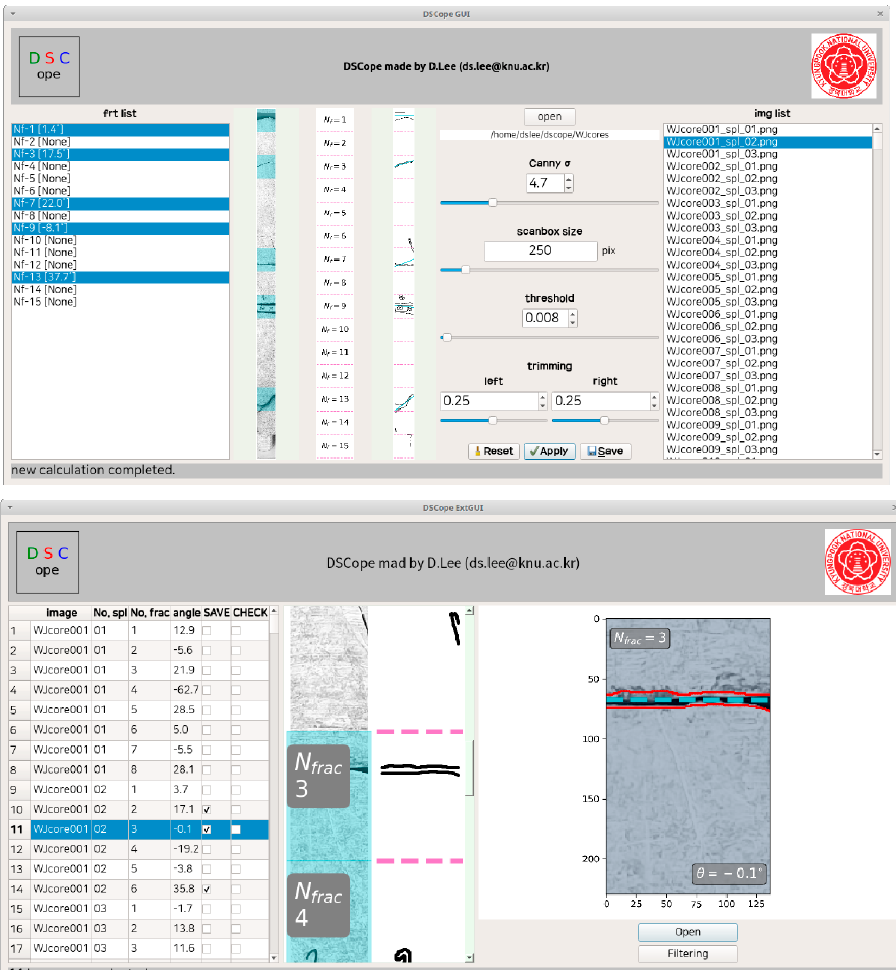
Figure 12. Examples of the second and third GUIs. The left panel shows that the second GUI displays the results as different parameters (e.g., Canny σ , scanbox size, threshold and trimming ratio) immediately. Then, saving only the selected output about each core is possible. Meanwhile, the right panel shows that the third GUI is helpful after obtaining the results through the last stage’s code. The third GUI helps to save the correct output by checking the box.